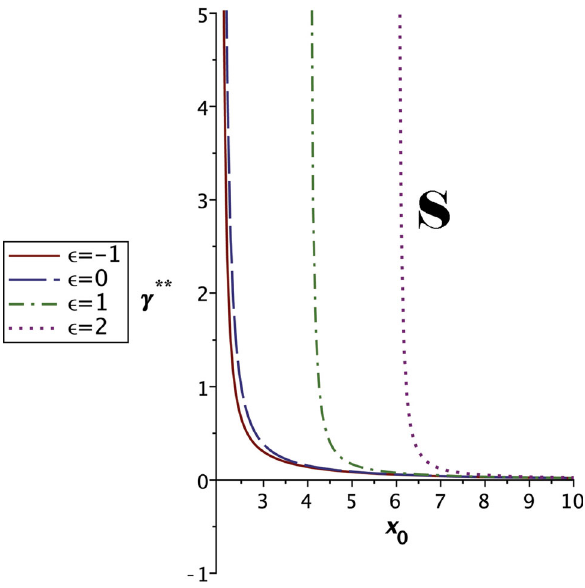
Fig. 7 The plots of β 2 versus x 0 are given for an S–S ∗ ATSW when γ = 1 /π M 2 x 2 while a (cid:18) = − 1, b (cid:18) = 0, c (cid:18) = 1, and d (cid:18) = 2. Both 0 the general shape and the ranges of the plot exhibit notable alterations with respect to the case of a barotropic EoS. A sign S implies the stable region